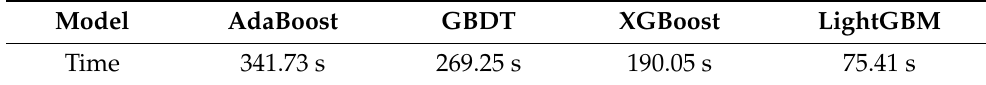
Table 4. Runtimes of the four models.